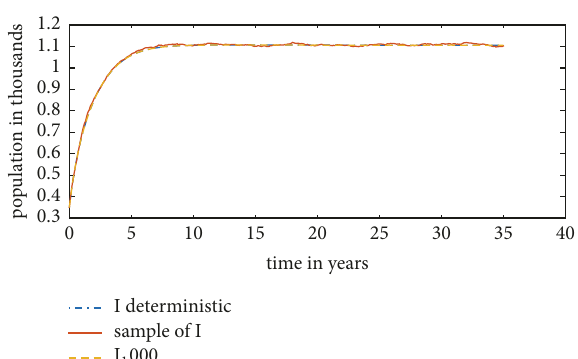
Figure 4: 𝑅 0 = 1.6900 , 𝑅 𝜎 = 1.4635 , and 𝑐 1 = 0.00007893 , 𝜎 = 0.04 with 𝑓 𝑆 = 0.2 , 𝑓 𝐸 = 0.74 , and 𝑓 𝐼 = 0.06 .